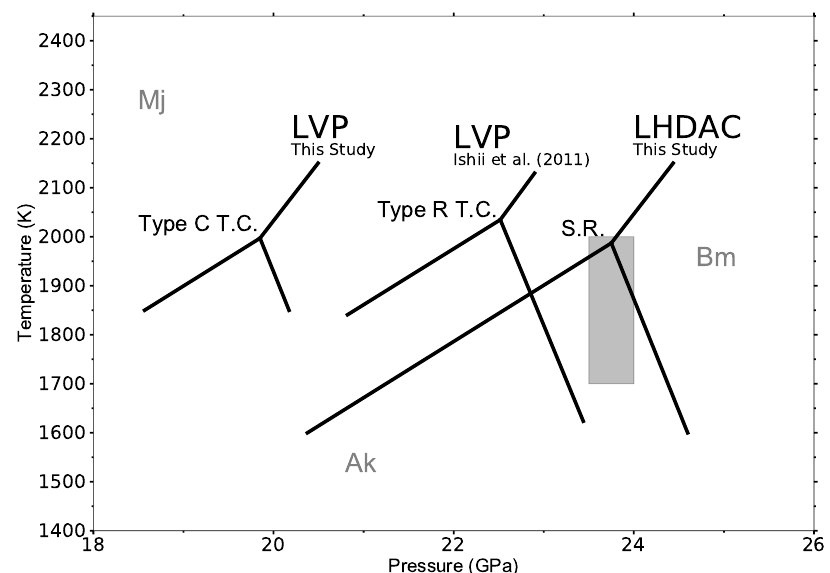
Figure 4. The phase boundaries between bridgmanite, akimotoite, and majorite and the triple point between them: The gray rectangular area represents pressure–temperature conditions expected for the 660-km discontinuity